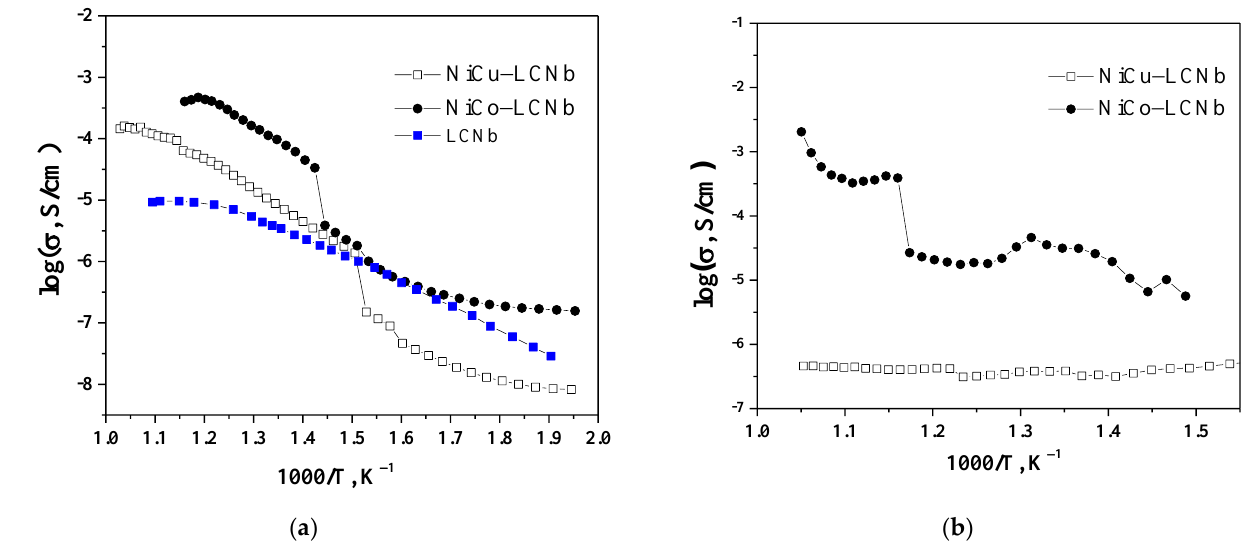
Figure 11. Total electric conductivity ( a ) and proton conductivity ( b ) of pelletized nanocomposites in wet He + 10% H 2 gas mixture.